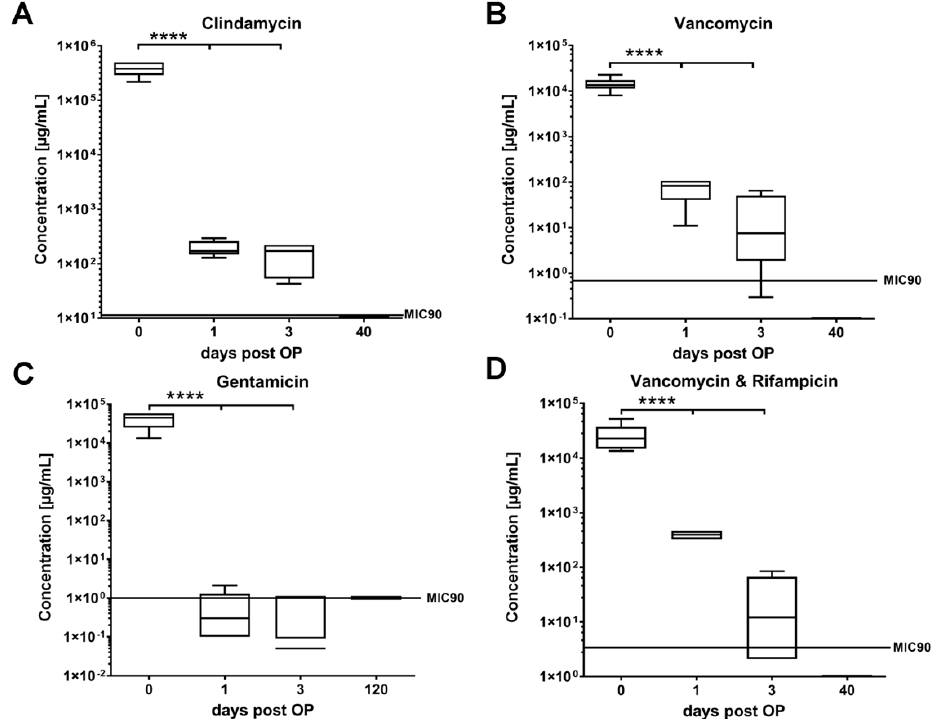
Figure 4. In vivo release kinetics of allogenic bone blocks at 1-, 3-, and 120-days post-implantation. Clindamycin ( A ), vancomycin ( B ), gentamycin ( C ), and vancomycin in combination with rifampicin ( D ). Significant differences ( p ≤ 0.0001) between initial values and other time points (1 and 3 days) are marked with four stars (****).